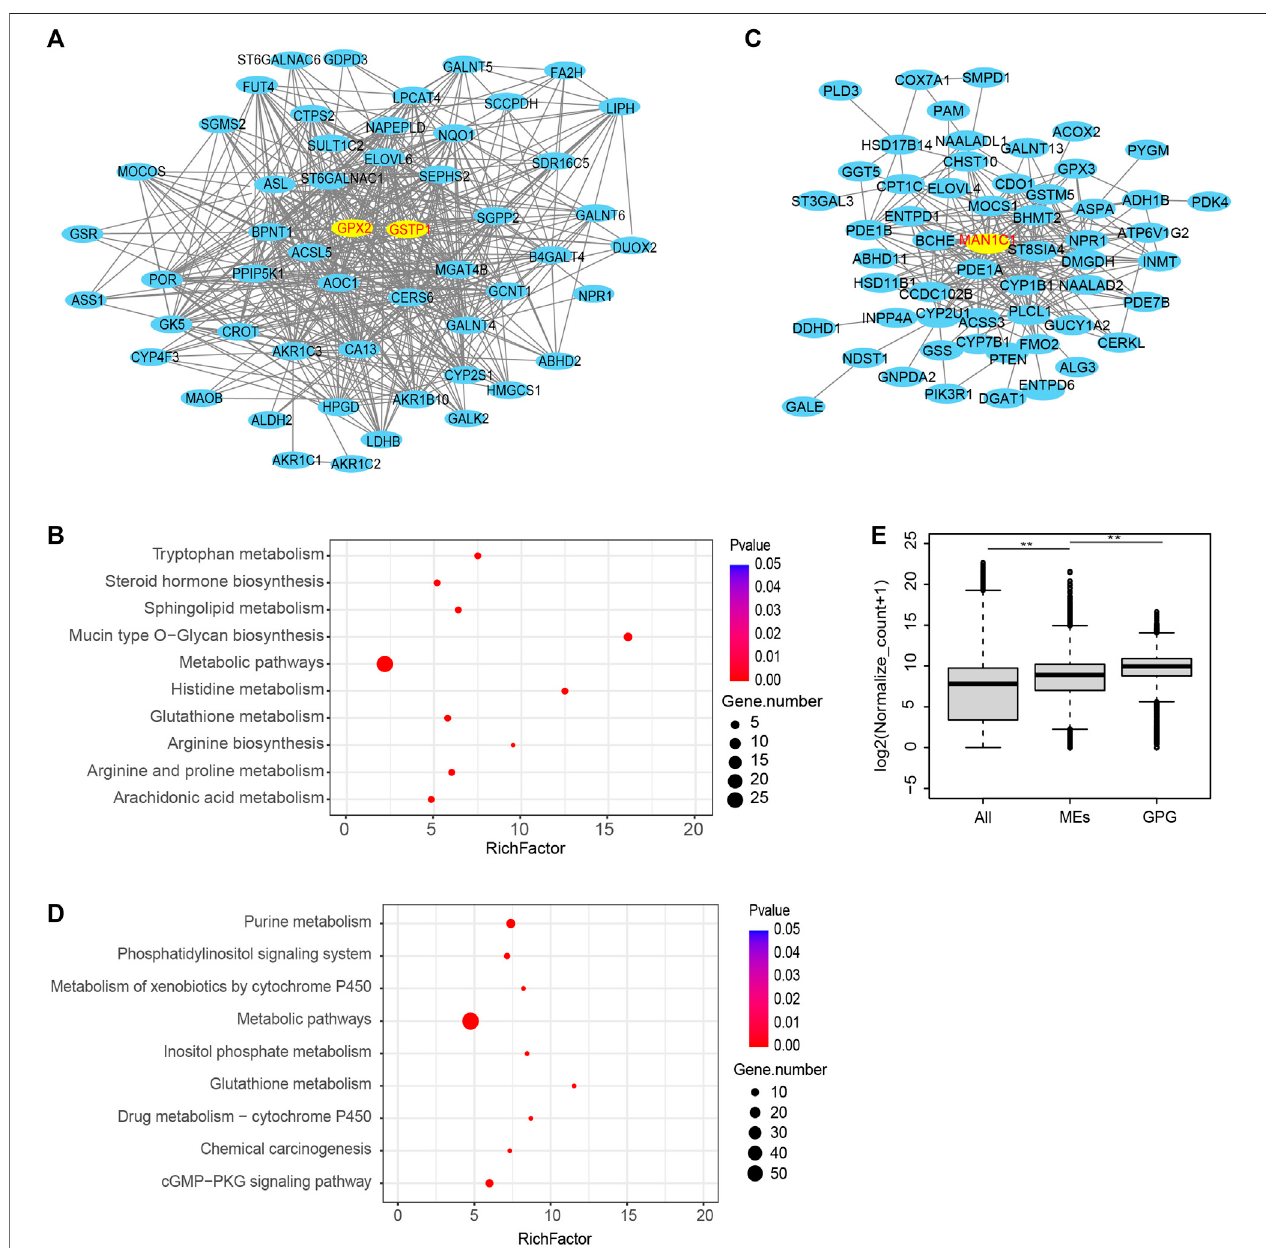
FIGURE 4 | PPI network of the two modules. (A) PPI network was analyzed using the black module of WGCNA in the GSE15471. (B) The KEGG pathway enrichment analysis for the black module. (C) PPI network was analyzed using the brown module of WGCNA in the TCGA. (D) The KEGG pathway enrichment analysis for the brown module in TCGA. (E) Comparison of the expression levels of the GPG and other metabolic pathway genes. (** p value < 0.01).